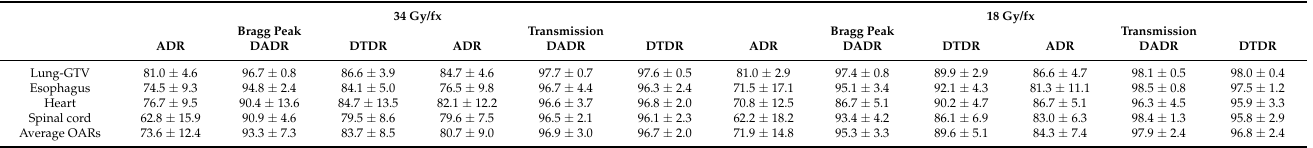
Table 1. V 40Gy/s results using different dose rate calculations for both the Bragg peak and transmission plans for 34 Gy/fx and 18 Gy/fx fractionations.